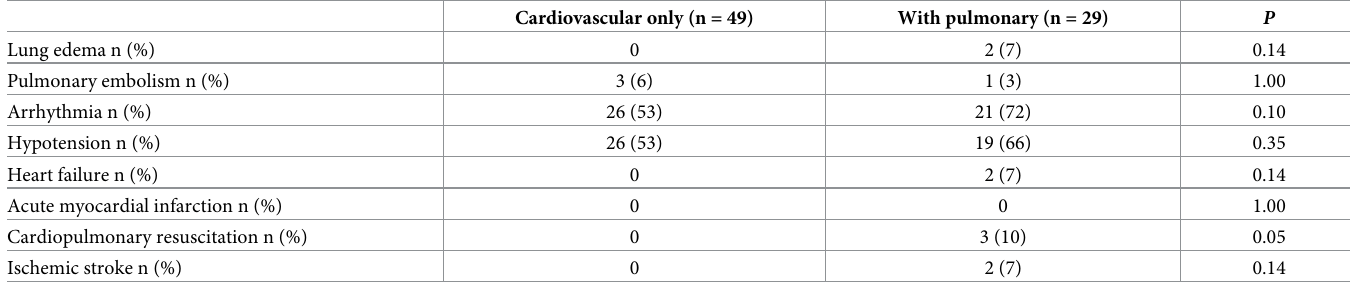
Table 1. Cardiovascular complications: Type and frequency (n =